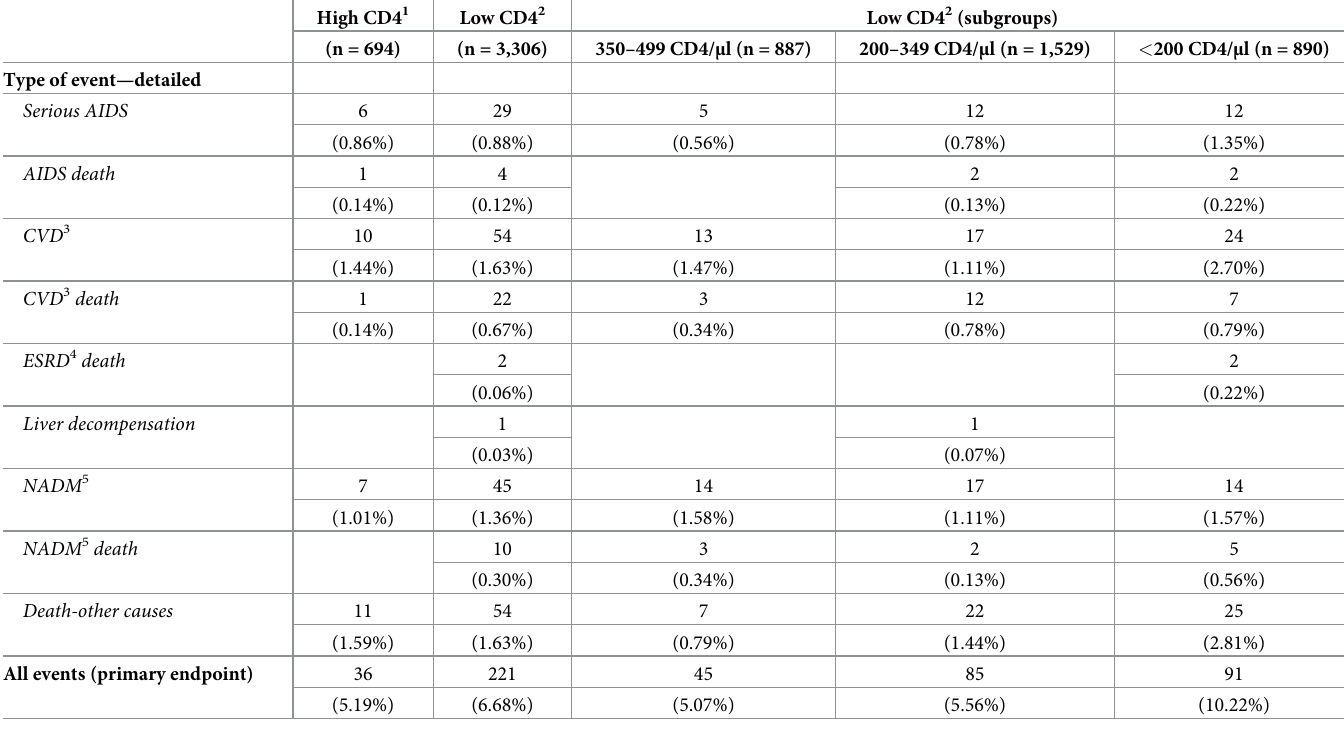
Table 2. Events [n (%)] observed between baseline date and end of follow-up by CD4 group and overall. “Low CD4” group stratified to subgroups. All numbers refer to the first event observed during follow-up (in case of multiple